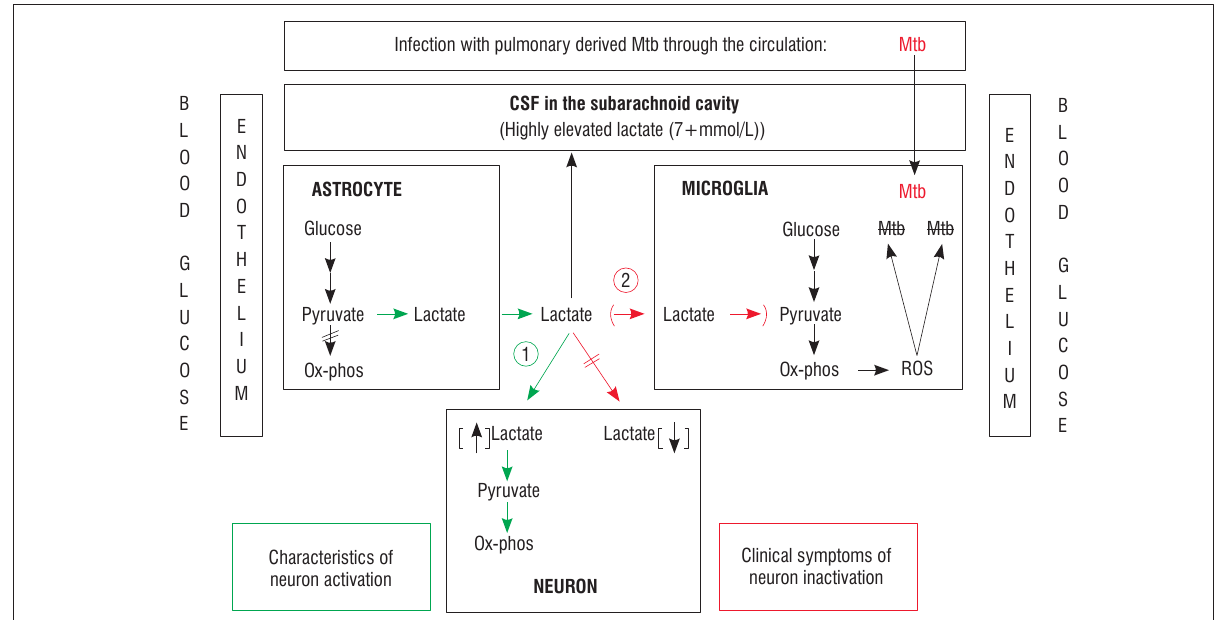
Figure 1: Representation of metabolic pathways of two lactate shuttles within the central nervous system. (1) The astrocyte–neuron lactate shuttle (ANLS; green pathway) 58 is operative under normal physiological conditions with astrocytes responding to glutamatergic activation by increasing their rate of glucose utilisation and release of lactate in the extracellular space, making the lactate available for neurons to sustain their energy demands. (2) The hypothetical astrocyte–microglia lactate shuttle (AMLS; red pathway) 52 proposed for tuberculous meningitis (TBM), with astrocytes responding to signalling from Mycobacterium tuberculosis (Mtb)-infected microglia by increasing glucose mobilisation, leading to increased extracellular lactate, reflected in increased cerebrospinal fluid (CSF) lactate levels, available as an additional energy source for reactive oxygen species (ROS) production aimed at destroying the invading